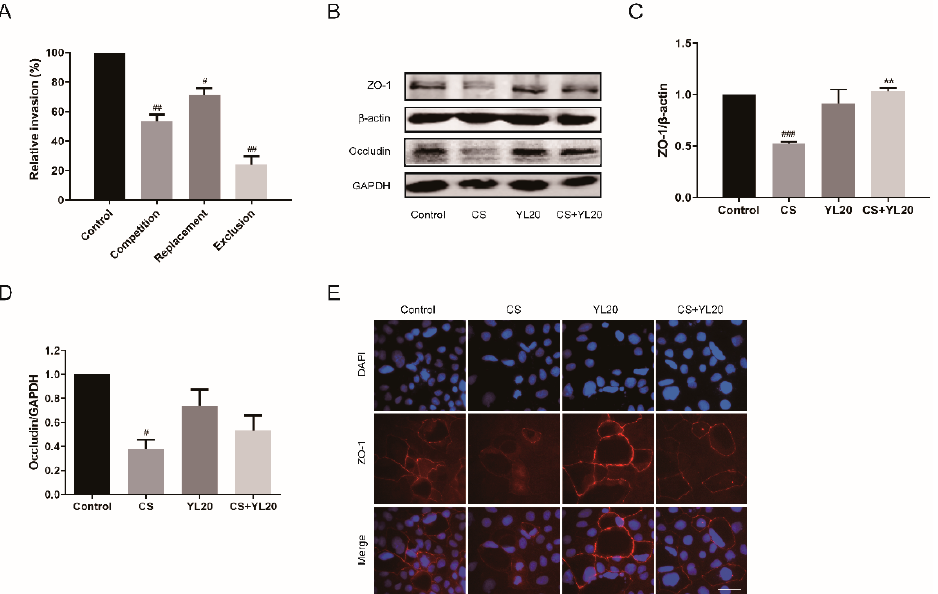
Figure 3. Effects of L. salivarius YL20 on C. sakazakii adherence to intestinal cells and the expression of TJ proteins in intestinal epithelial cells. ( A ) Effects of YL20 on C. sakazakii invasion of HT-29 cells. The results were presented as the percentage of the invasive bacteria (% CFU invasive bacteria in the experiment group/CFU invasive bacteria in the control group). ( B ) Western blotting analysis of the effects of YL20 on the expression of ZO-1 and occludin in C. sakazakii -infected HT-29 cells. ( C , D ) Quantification of the TJ proteins using Image J software. ( E ) Immunofluorescent staining analysis of ZO-1, scale bar = 50 μ m. # p < 0.05, ## p < 0.01, ### p < 0.001 vs. Control group; ** p < 0.01 vs. CS group; n = 3.